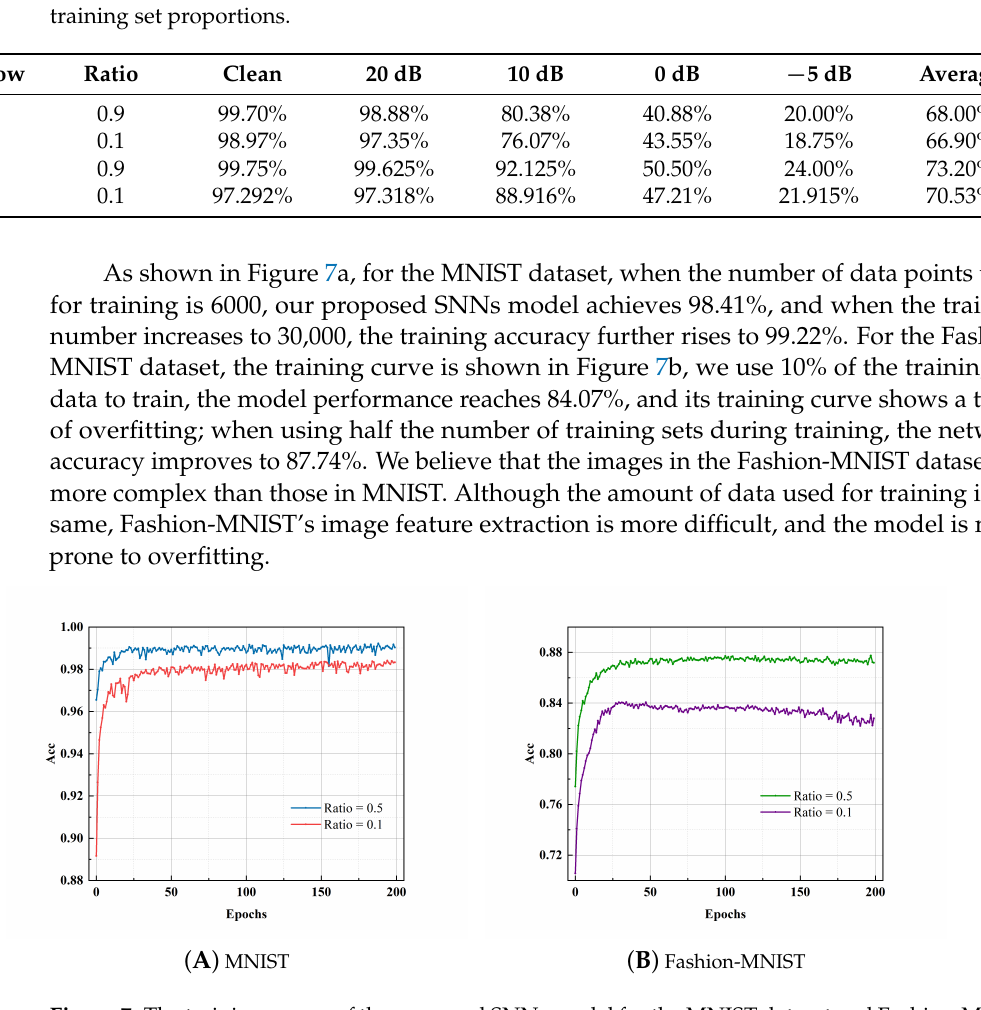
Figure 7. The training curves of the proposed SNNs model for the MNIST dataset and Fashion-MNIST dataset when the ratio of training data to the training set is 0.5 and 0.1, respectively. ( A ). Although there are fewer training data sets for the MNIST dataset, the network training curve is still flat. Even with a ratio of 0.1, the training accuracy still reaches 98.41%. ( B ). The Fashion-MNIST dataset’s image content is comparatively sophisticated. The training curve shows that the network tends to overfit when there are fewer data available for